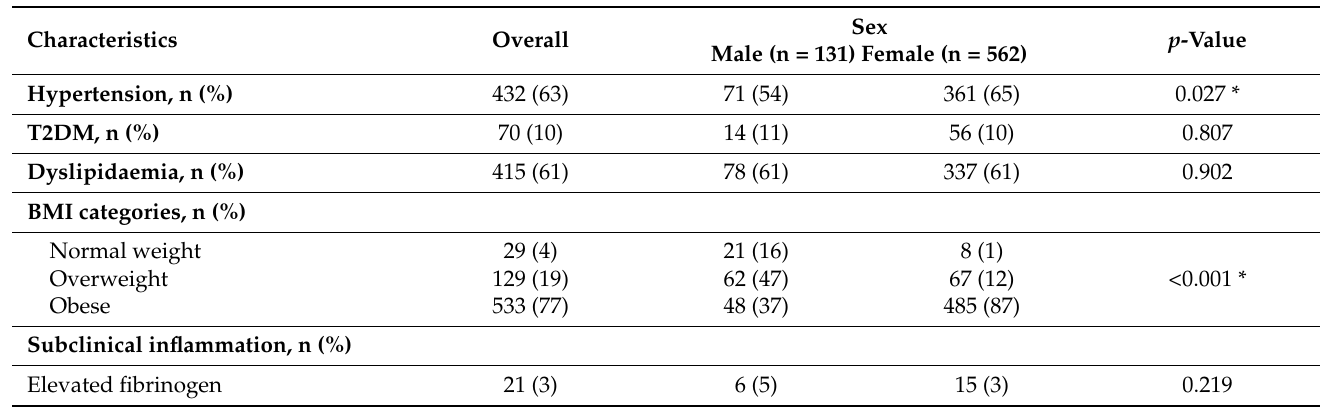
Table 4. Prevalence of CVD risk factors.